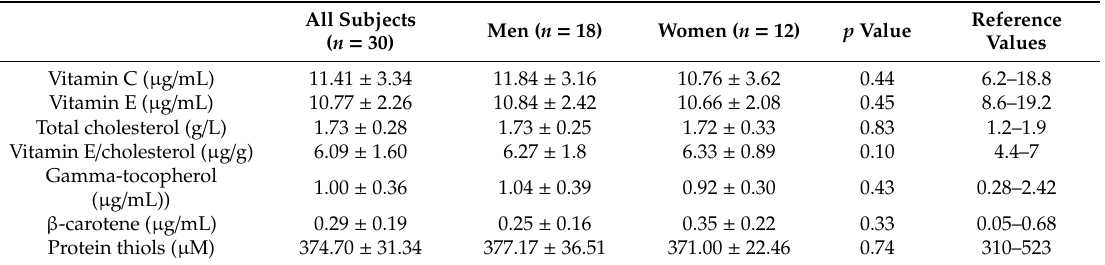
Table 5. Comparison of blood and urinary OS biomarkers, antioxidant intake and PAOT-Skin Score ® between males ( n = 18) and females ( n = 12) belonging to Group